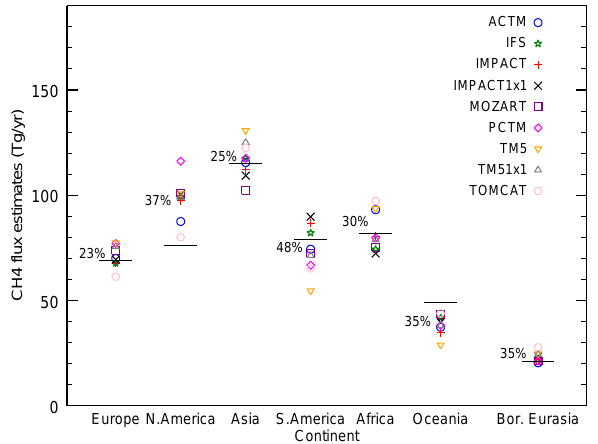
Fig. 10. Inverted CH 4 fluxes at regional scale. Seven continental regions are displayed here (Europe, North America, Asia, South America, Africa, Oceania and Boreal Eurasia). Every symbol shows the estimated value for a specific TransCom model and for a spe- cific region. The percentage indicates the spread of the estimates as a whole for every region. The black lines show the target methane regional estimates.